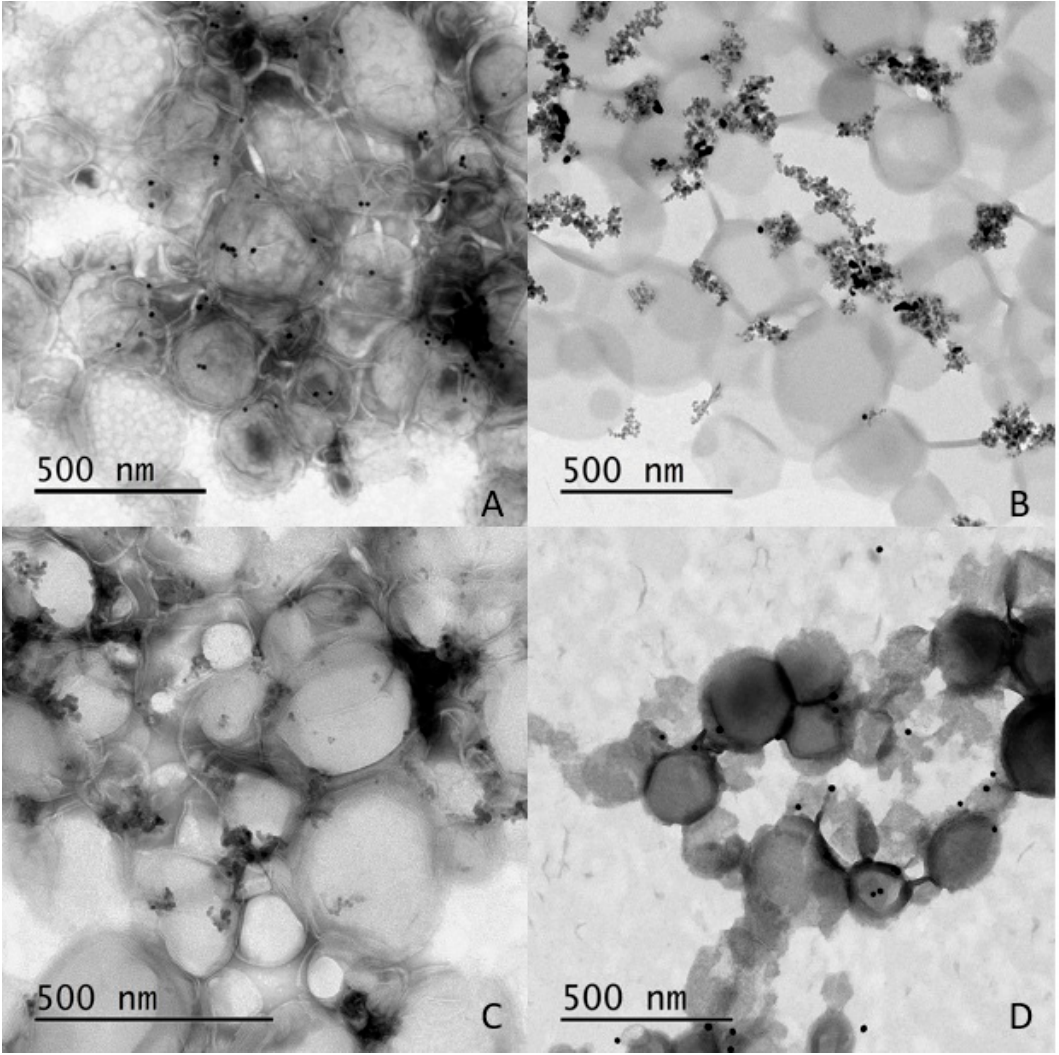
Figure 3. TEM images. ( A , B ) Thiolated liposomes with gold coated synthetic iron oxide NPs. ( C ) Thiolated liposomes with gold coated commercial iron oxide NPs. ( D ) Regular liposomes with gold coated commercial iron oxide NPs. (See the supplementary materials, Figure S7, for the rest of the images that exhibit the chemisorption of gold coated MNPs on the liposomal surface by gold–thiol bonds). 2.3. Changes in the Transition Temperature of the Liposomes upon Addition of Nanoparticles Two di ff erent types of liposome samples (regular liposomes with no thiol groups and thiolated liposomes with 50% Th-CHOL) are allowed to interact with di ff erent types of nanoparticles. The percentage photoluminescence (PL) intensity vs. temperature graphs (Figure 4A,B) show that addition of nanoparticles results in a change of transition temperature of liposomes. For the regular liposomes without thiol groups (Figure 4A), the change in transition temperature (with reference to a sample without nanoparticles) is negligibly small upon addition of the iron oxide NPs and gold nanoparticles (AuNPs 40 nm size), while there is small change (decrease by approximately 3 interacting with 50 nm in size gold coated iron oxide NPs. These indicate that there is no significant interaction between the liposomes and nanoparticles. However, for the thiolated sample (Th-Chol 50%) in Figure 4B, the interaction with nanoparticles is such that the transition temperature changes by ◦ 3 to 8